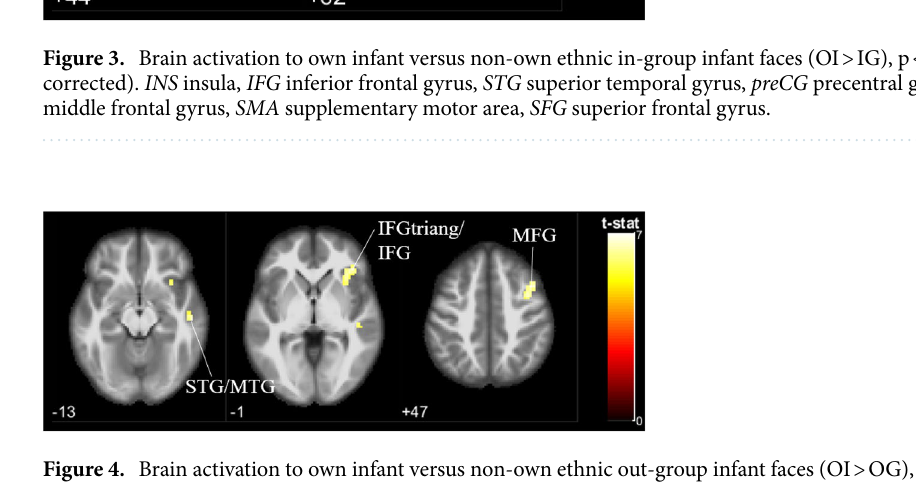
Figure 4. Brain activation to own infant versus non-own ethnic out-group infant faces (OI > OG), p < 0.05 (FWE corrected). STG superior temporal gyrus, MTG middle temporal gyrus, IFGtriang pars triangularis of the inferior frontal gyrus, IFG inferior frontal gyrus, MFG middle frontal